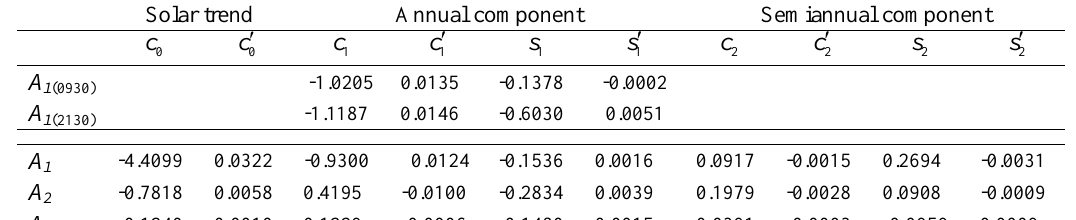
Table 3. List of fitting coefficients with respect to the Eqs. (3) and (6). Table 3 . List of fitting coefficients with respect to the Eqs. (3) and (6).